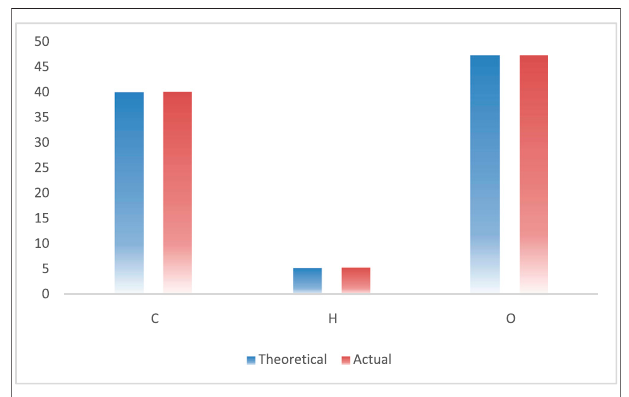
FIGURE2 | Elemental analysis fornano fi bers based oncyclodextrin and egg shell waste.